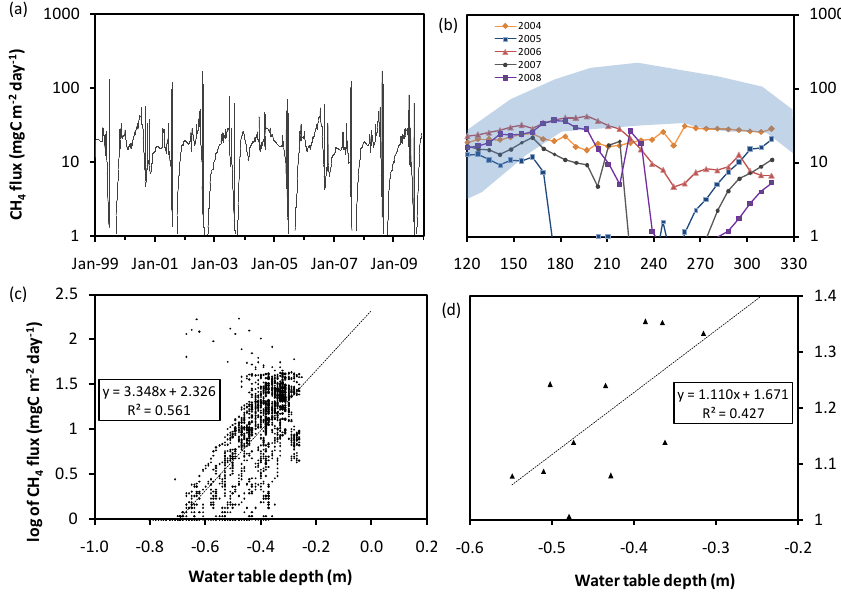
Figure 8. Time series of (a) simulated daily CH 4 flux (mg C m -2 day -1 ) from 1999 to 2009, (b) simulated growing season (day of year 120 to 330) daily CH 4 flux (mg C m -2 day -1 ) from 2004 to 2008 (blue area indicates the variation range as recoreded for the Mer Bleue Bog averaged from 12 collars (Moore et al. 2011, Fig. 2), (c) relationship between the simulated growing season daily and (d) annual average CH 4 flux (mg C m -2 day -1 ) in log 10 scale and the simulated daily water table depth (m) from 1999 to 2009.